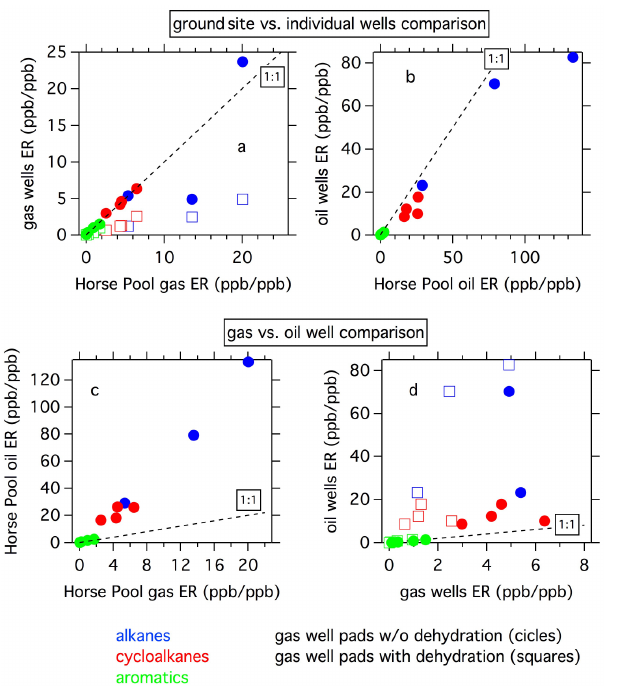
Figure 11. Enhancement ratios with benzene of aromatics (green), cycloalkanes (red) and masses measured with the PTR-MS that are indicative of alkanes in arbitrary units (blue). (a) Gas well pads without dehydration (circles) and gas well pads with dehydration (squares) compared to the gas well sector from the Horse Pool ground site data; (b) oil well pads compared to the oil well sector from the Horse Pool ground site data; (c) oil well sector compared to the gas well sector for the Horse Pool ground site data; and (d) oil well pads compared to gas well pads from the mobile laboratory data.